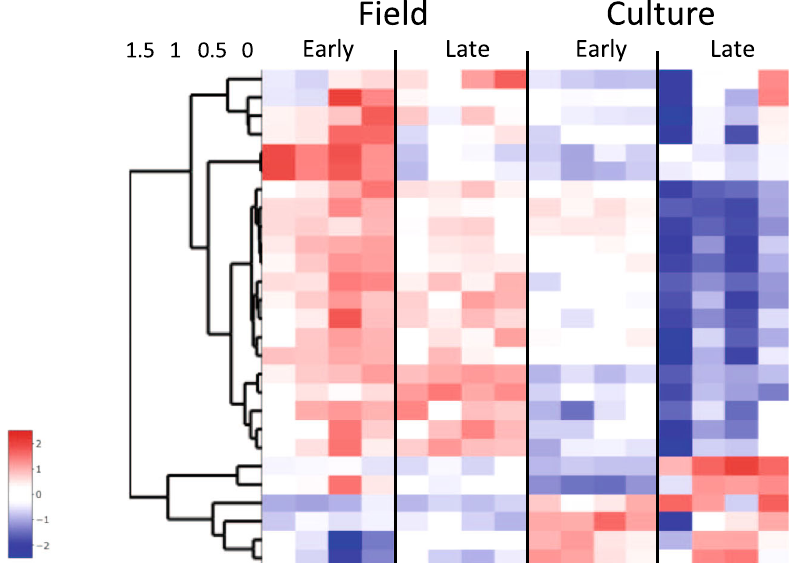
Fig. 7 Expression heatmap showing z-scores of DEGs involved in fatty acid biosynthesis. Differentially expressed genes between fi eld/diapause program and culture/reproductive program and early and late CV copepodids annotated with the GO term ‘ fatty acid biosynthetic process ’ [GO:0006633] or its child terms ( n = 23). Color-coding for each gene indicates the magnitude of expression as z-scores of each individual sample. Relative expression of each sample is given in a separate column (ordered by group) as labeled at the top. Genes (rows) were ordered by hierarchical